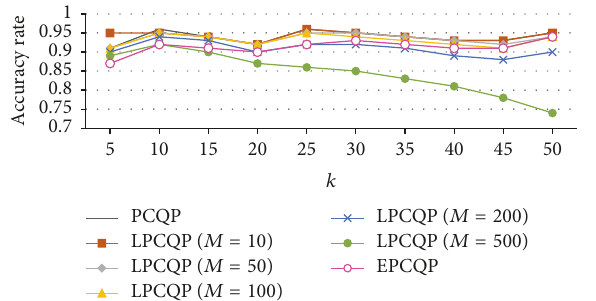
Figure 6: Query accuracy rate versus k of the uniform dataset.